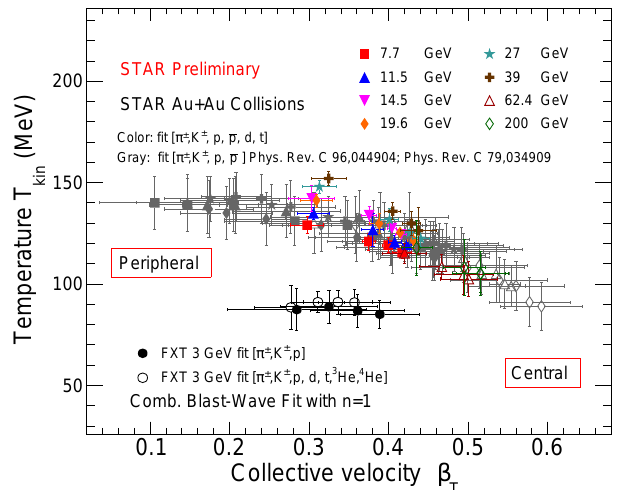
(cid:112) = 3, 7.7, 11.5, 14.5, s NN